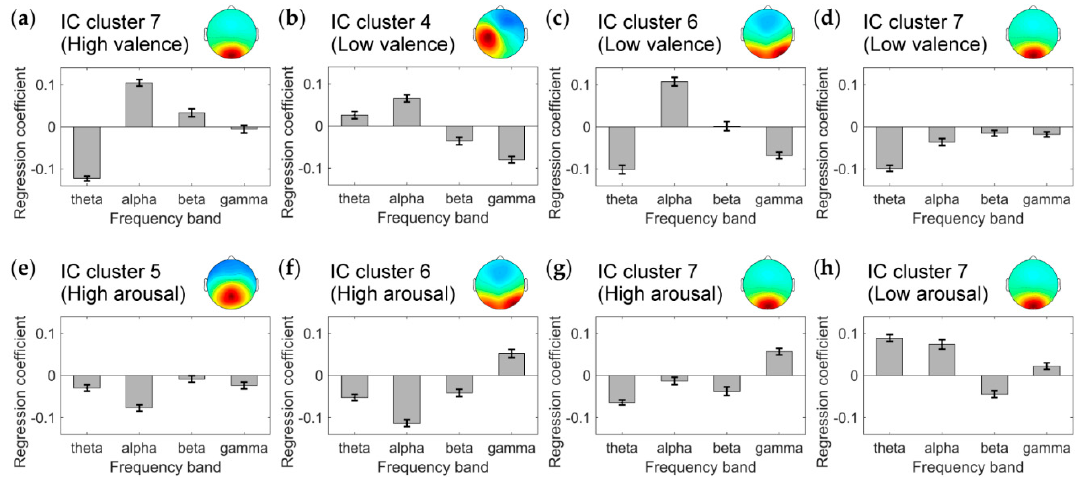
Figure 5. Mean coefficients of the theta, alpha, beta, and gamma bands in the regression model. Larger absolute value of the regression coefficient indicates larger degree of contribution of the frequency band to the regression model. Positive (negative) regression coefficient indicates positive (negative) relationship between the frequency band power and IAPS normative ratings. Error bars represent standard deviations. ( a ) Regression of the high-valence state of IC cluster 7. ( b ) Low-valence state of IC cluster 4. ( c ) Low-valence state of IC cluster 6. ( d ) Low-valence state of IC cluster 7. ( e ) High-arousal state of IC cluster 5. ( f ) High-arousal state of IC cluster 6. ( g ) High-arousal state of IC cluster 7. ( h ) Low-arousal state of IC cluster 7.